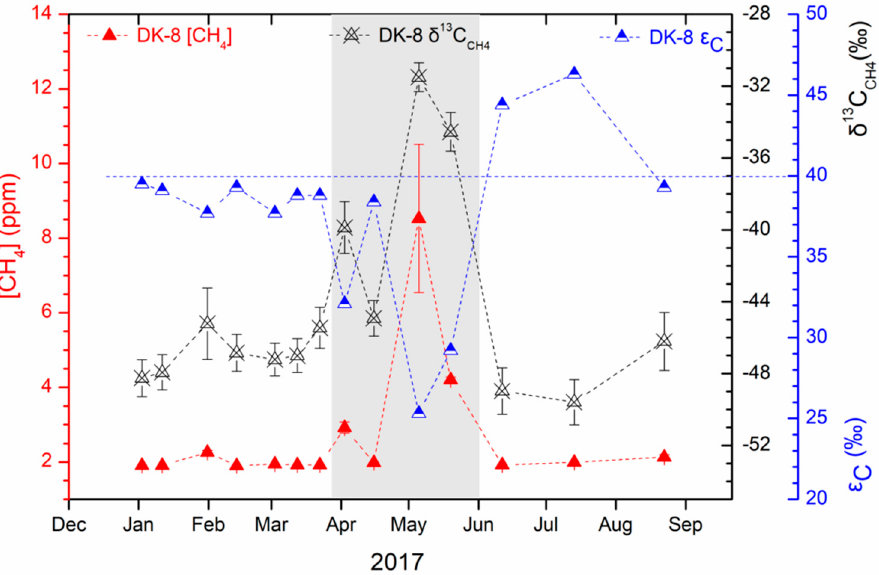
Figure 4. Content and stable carbon isotopic composition ( δ 13 C CH4 ) of methane and carbon isotope separation ( ε C ) between CH 4 and CO 2 effused from the gas hydrate drilling well DK-8.